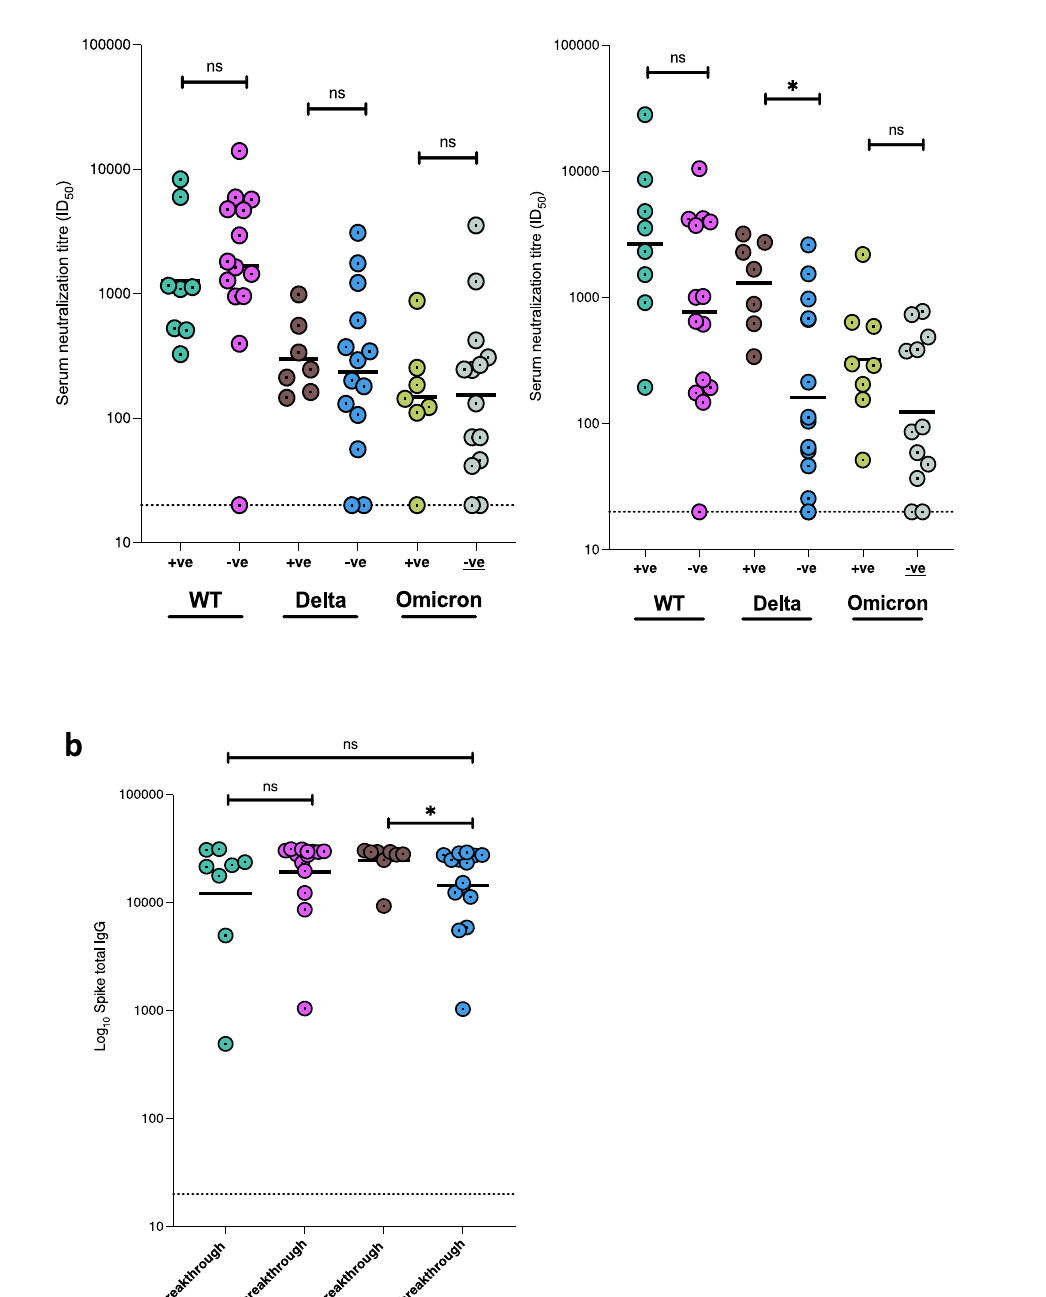
Fig. 5 | Neutralising and binding SARS-CoV-2 antibody responses one and 3months aftervaccinationin context ofbreakthroughinthe Nigeriancohort. a Serum neutralization against pseudotyped virus from individuals with vaccine breakthrough occurring between months 1 and 3 post second dose and with no evidence of previous infection prior to vaccine ( n =8, N antibody +ve), and those without breakthrough or past infection prior to vaccine ( n =15, N antibody − ve).